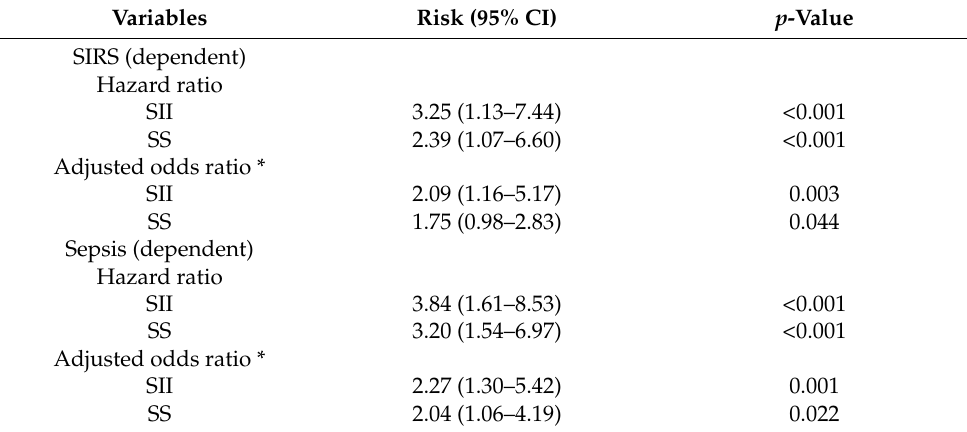
Table 5. Hazard ratios and adjusted odds ratios for SII and SS scores were calculated at admission for predicting SIRS and sepsis after odontogenic infections.